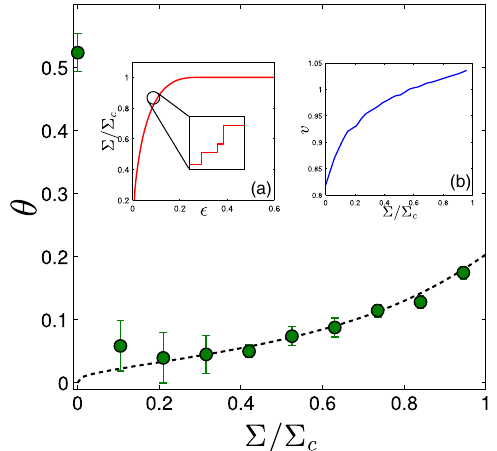
FIG. 5. θ as a function of the relative stress Σ = Σ c , where Σ c is the yield stress for μ ¼ 1 , A ¼ 0 . 3 , and N ¼ 1024 2 . Right after the quench, θ ¼ 0 . 53 (cid:3) 0 . 03 . As Σ is increased, a sharp drop to a lower value occurs. Inset (a): The stress vs plastic strain curves. Zooming in on a finite-size system reveals a staircase. Inset (b): The bias v ’ s dependence on Σ = Σ c , from which we get the black dashed line in the main panel as the theoretical prediction using Eq.